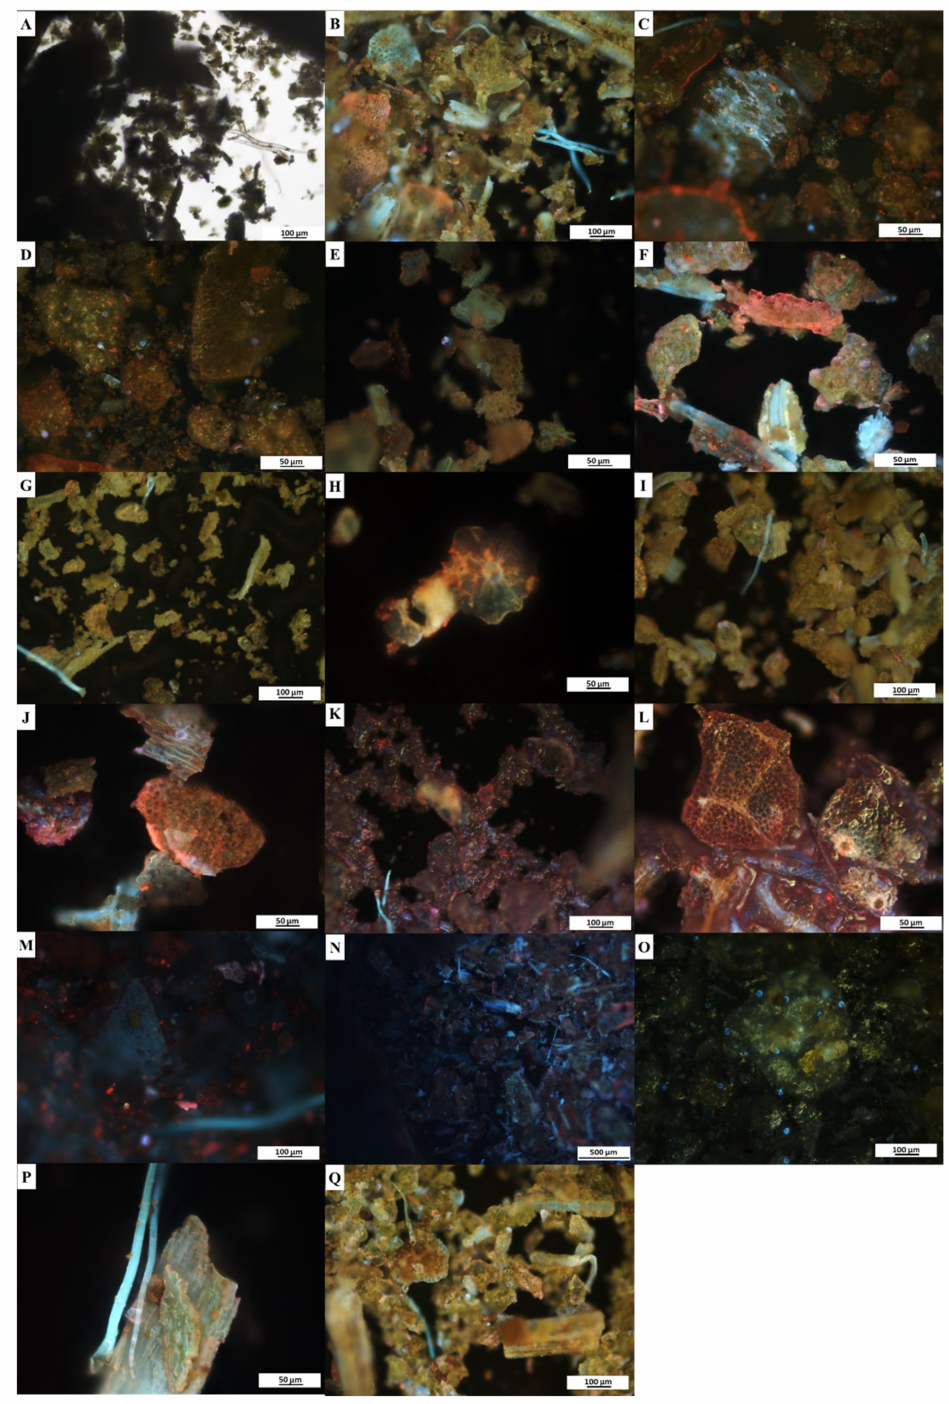
Figure 3. Fluorescence microanalyses of powdered leaf material of Combretum molle . Powder only un- der ( A ) brightfield and ( B ) UV light (control); powder treated with: ( C , D ) distilled water; ( E ) hexane; ( F ) chloroform; ( G , H ) methanol; ( I , J ) ethanol; ( K , L ) acetic acid; ( M ) sodium hydroxide; ( N ) sulphuric acid; ( O ) hydrochloric acid; and ( P , Q ) acetone under UV